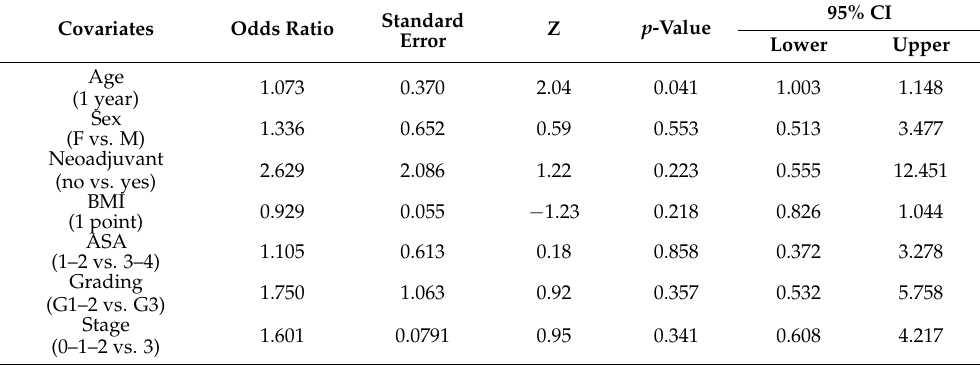
Table 5. Logistic regression OG.